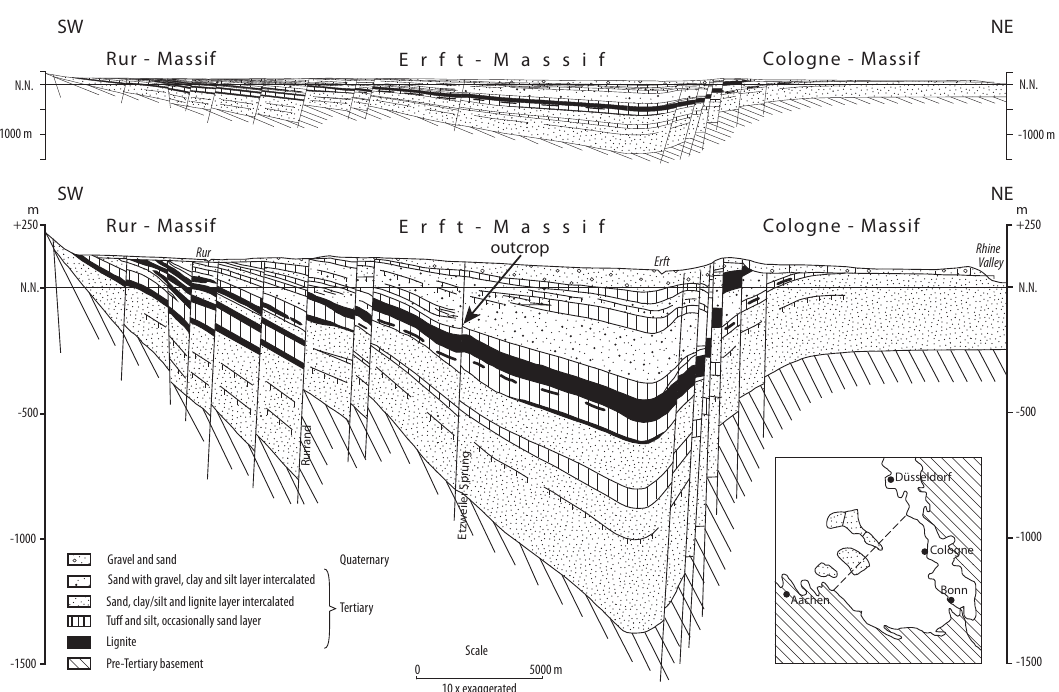
Figure 1. SW–NE profile of the Lower Rhine Embayment including the Etzweiler Sprung. An arrow points towards the location and depth of the outcrop. Modified after Knufinke and Kothen